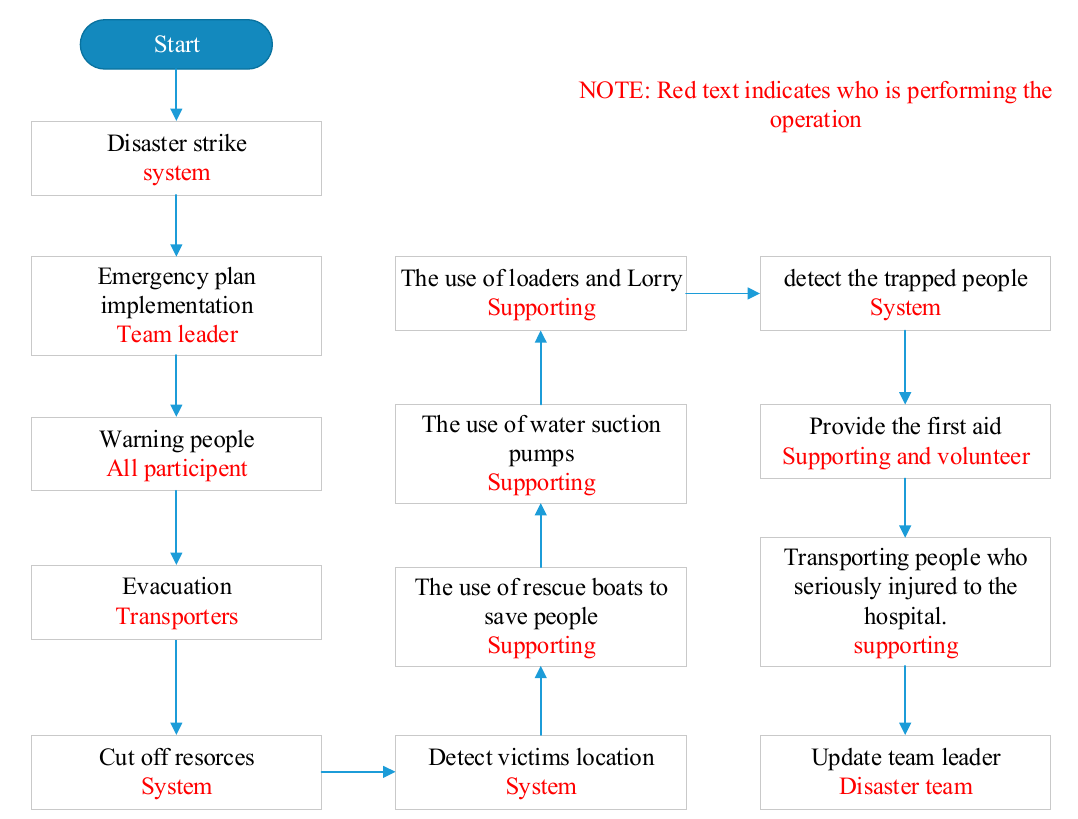
Figure 2. Flowchart of detailed activities of flooding during disaster stage [39].